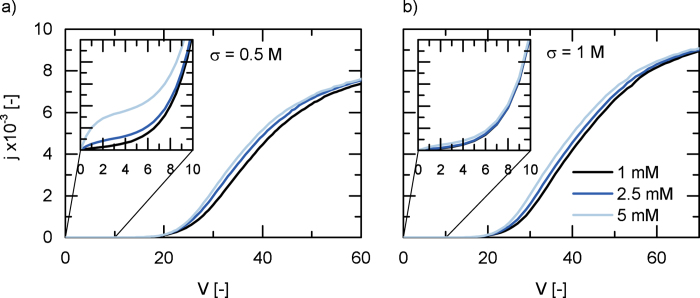
Current-voltage behaviour of a BPM comprising a 2 nm junction for varying concentrations of salt.Membrane charge density is σAEM = σCEM = a) 0.1 M b) 1 M.